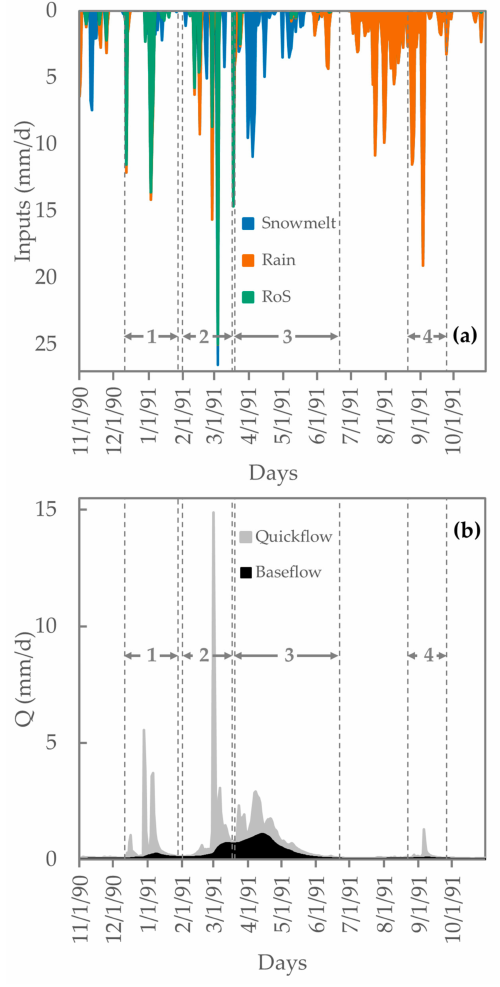
Figure 7. Daily snowmelt, rain, and rain-on-snow (RoS) inputs ( a ) and daily discharge (Q) separated into quickflow and baseflow components ( b ) in Black River Fort Apache (BLF) sub-basin in White Mountains from water year (WY) 1991. Numbered vertical dotted lines denote four quickflow response intervals (QRIs) identified in WY. Inputs in ( a ) and area-normalized streamflow components in ( b ) are stacked such that the width of all bands represents the total daily input and discharge,